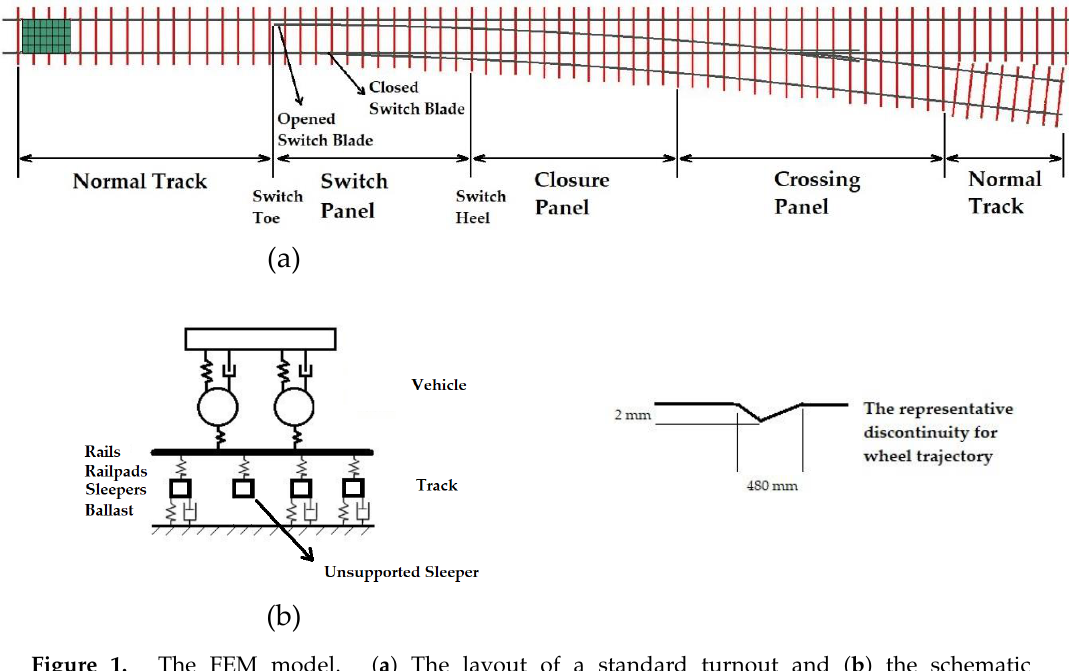
Figure 1. The FEM model. ( a ) The layout of a standard turnout and (b) the schematic vehicle–track couple.